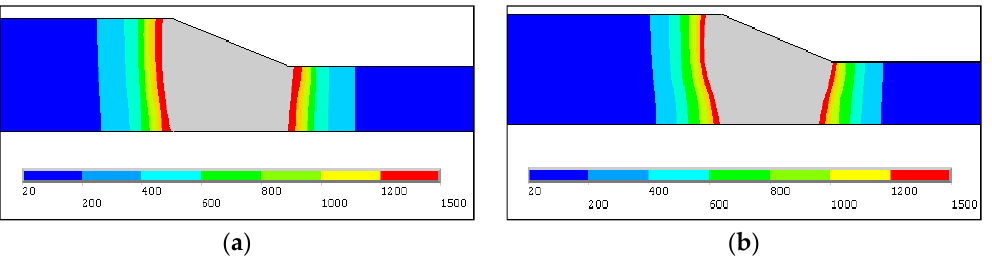
Metals 2019 , 9 FOR PEER REVIEW Figure 11. The calculated weld cross-section of tailored blanks cross-section (1:1 power ratio,1800 W total power, and 1.2 m/min welding speed): ( a ) The arrangement mode I; ( b ) the arrangement mode II.